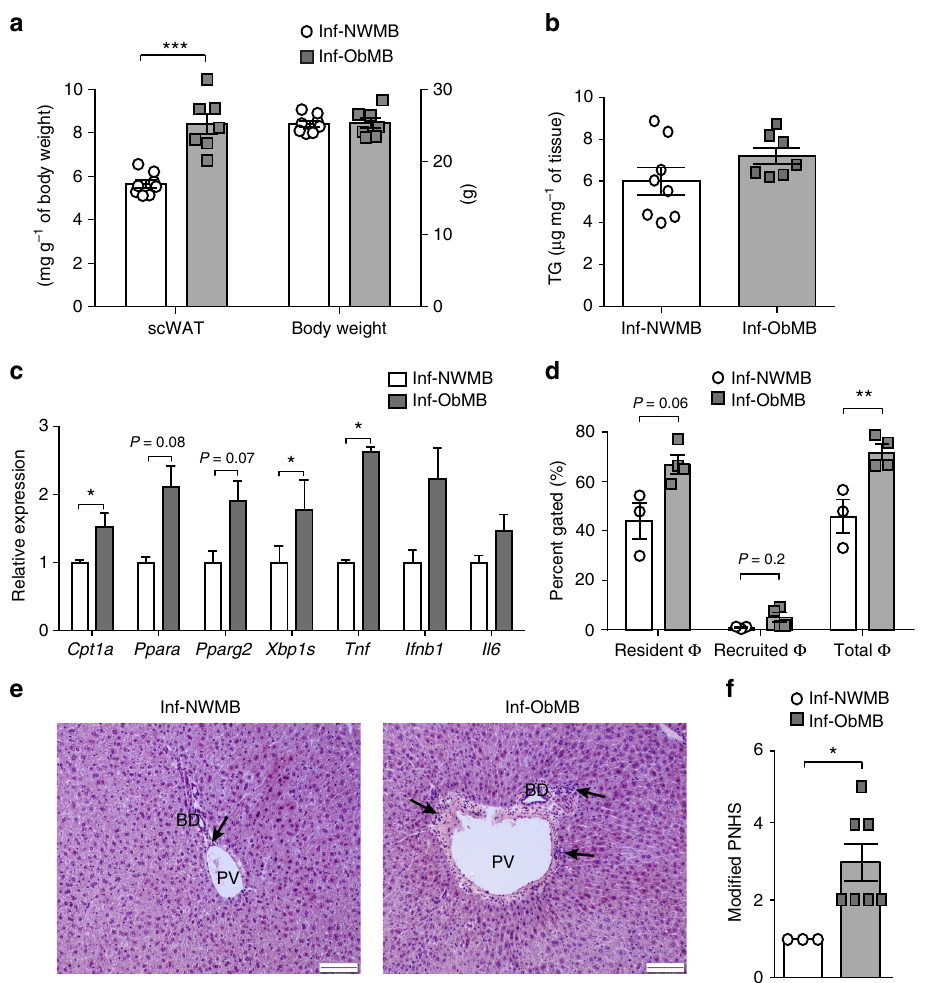
Fig. 4 Inf-ObMB increases subcutaneous fat and liver in fl ammation. Weight of subcutaneous white adipose tissue (scWAT) and body weight ( a ), and liver triglycerides (TG) ( b ); n = 8 for Inf-NWMB, n = 7 for Inf-ObMB. c Hepatic expression of lipid regulatory and in fl ammatory genes normalized to Gapdh and 18S rRNA; n = 6 for Inf-NWMB, n = 7 for Inf-ObMB (except Tnf , n = 3/group). d Hepatic resident, recruited, and total macrophage ( Φ ) quantities; n = 3 for Inf-NWMB, n = 4 for Inf-ObMB. a – d Data are presented as mean ± SEM. * P < 0.05, ** P < 0.01 and *** P < 0.005 by two-tailed Student ’ s t -test. e Representative photomicrographs of H&E staining in the liver from Inf-NWMB and Inf-ObMB mice; black bars represent 100 μ m, black arrows indicate in fi ltrating lymphocytes; PV portal vein, BD bile duct. f Modi fi ed Pediatric NAFLD Histological Score (PNHS) for Inf-NWMB and Inf-ObMB mice. n = 3 for Inf-NWMB and n = 7 for Inf-ObMB. Data are presented as mean ± SEM. * P < 0.05 by two-tailed Mann – Whitney U